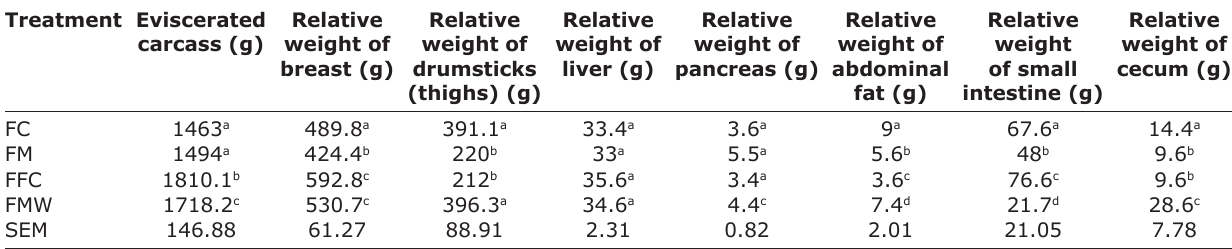
Table-3: Carcass yield mean (±SEM) of Ross 40 broilers fed with different agroindustrial waste sampled from postnatal 1 st -6 th weeks*. Treatment Eviscerated Relative carcass (g) weight